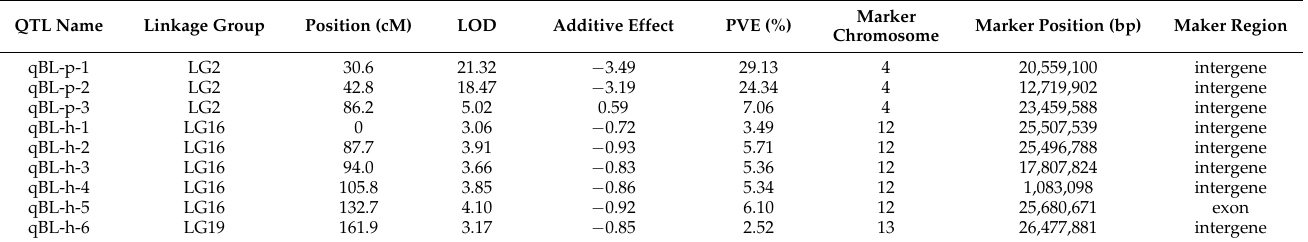
Table 2. Information on body length-related QTLs in Yellow River carp at 5–9 months after hatching.